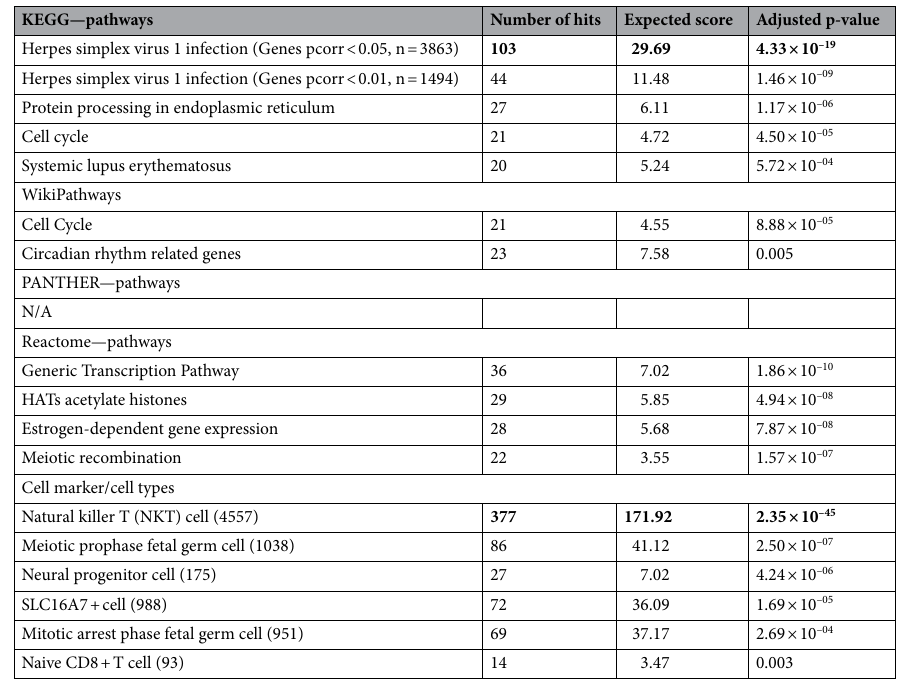
Table 4. Enriched pathways among the top 1494 differentially expressed genes (DEGs) from the DESeq2 analysis of healthy mucosa from control vs non-polyp mucosa from patient with CRSwNP. Analyzed using GeneTrail 3.0 30 . p -values adjusted using the Benjamini-yekutieli method. (Genes p -value adjusted < 0.01, n = 1494). Significant values are in bold.